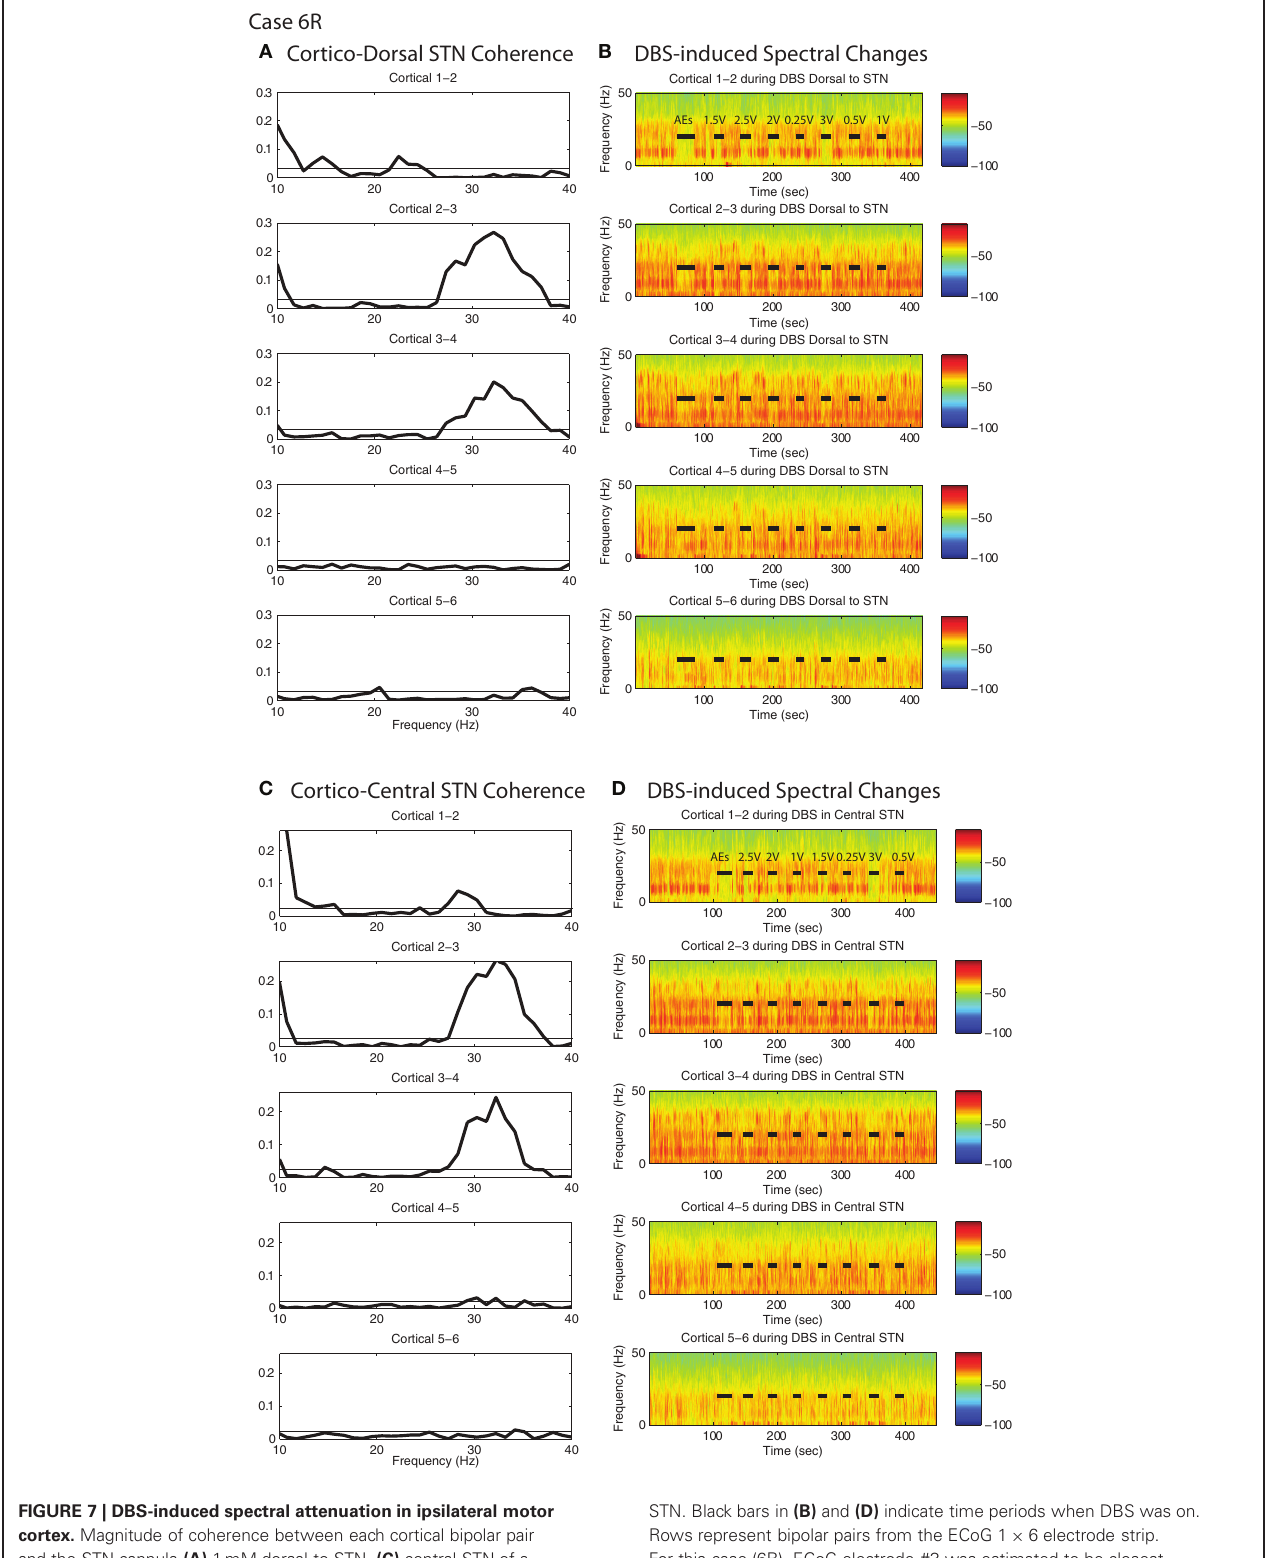
FIGURE 7 | DBS-induced spectral attenuation in ipsilateral motor cortex. Magnitude of coherence between each cortical bipolar pair and the STN cannula (A) 1mM dorsal to STN, (C) central STN of a representative patient (case 6R). Spectrograms of motor cortex ECoG during HF DBS (B) 1.5mM dorsal to the STN, and (D) within the central